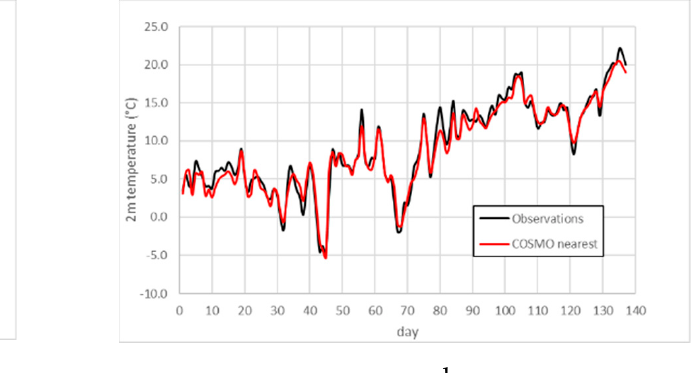
Figure 4. Time series of daily t2m (°C) at Napoli Capodichino ( a ) and Montemarano ( b ) over the considered period: ob- servational and model data for the nearest grid point. Table 1. Mean, maximum positive and maximum negative temperature bias (°C) and RMSE (°C) of the model against observational data. Index of agreement d (non-dimensional). Both nearest point and grid box values are shown.